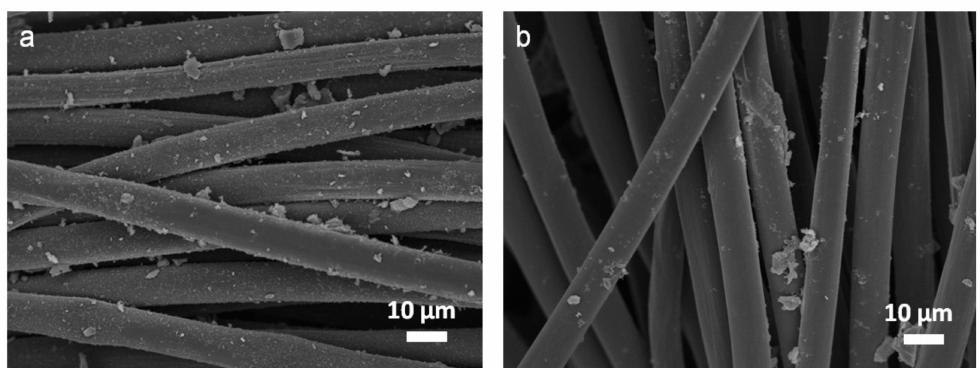
Figure 1. SEM images showing the surface morphologies of ( a ) ACAGSpP- and ( b ) ACPVDFSpP-decorated CFCs.